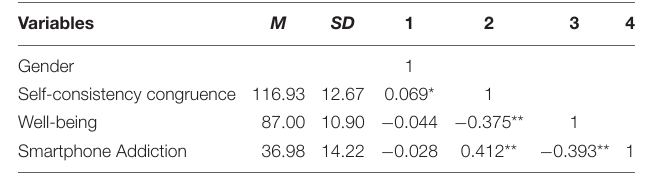
TABLE 1 | Correlation analysis of